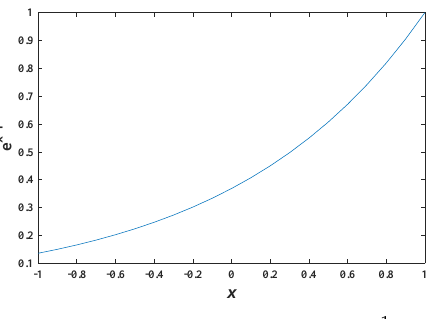
Figure 6. The curve of function e x − 1